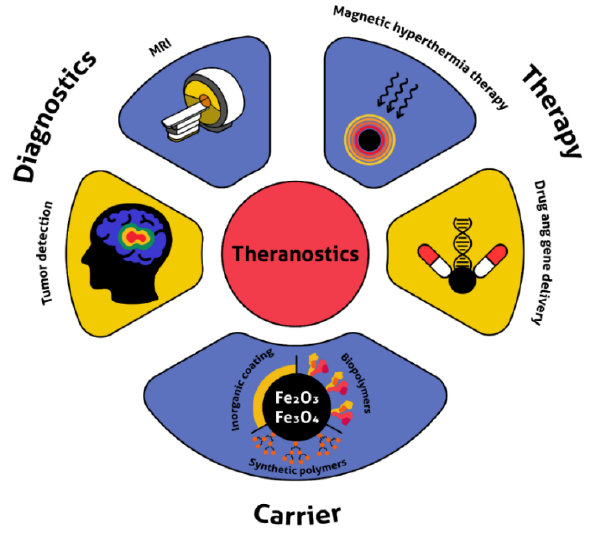
Figure 6. Therapy and diagnostics application combination